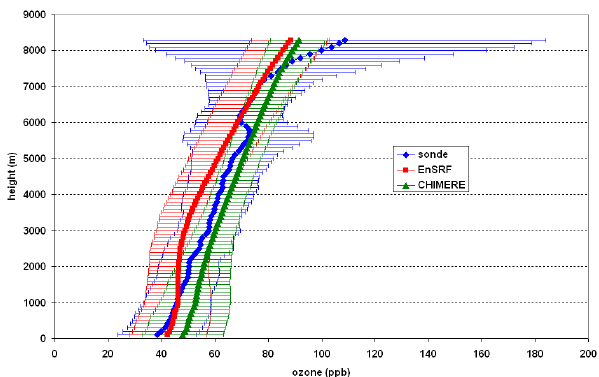
Figure 10. Comparison between the averaged vertical profile of MOZAIC aircraft (average calculated over 83 profiles) (blue curve) with the mean profile calculated over the analysed ensemble, called EnSRF, (red curve) and a mean profile drawn from a reference run “without assimilation”, called CHIMERE (green curve). The error bars correspond to the standard deviation of the mean.